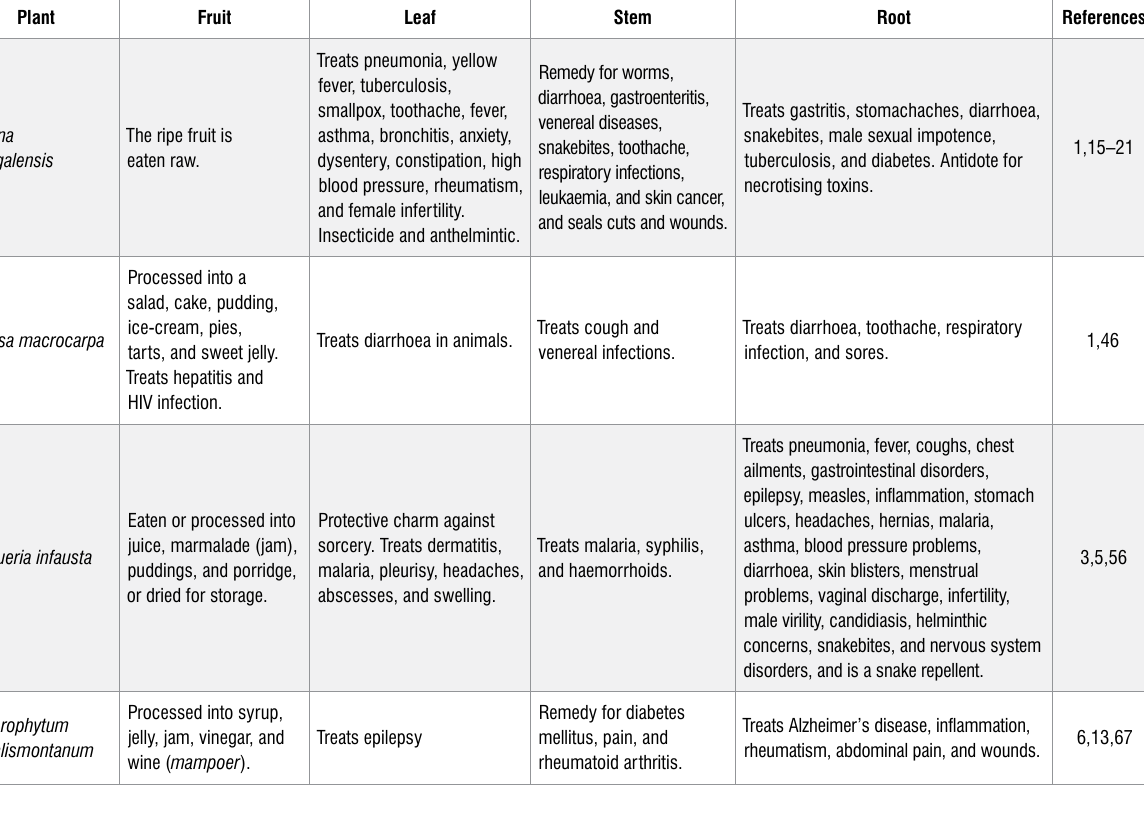
Table 1: Ethnopharmacological uses of the various parts of the four plants under review Plant